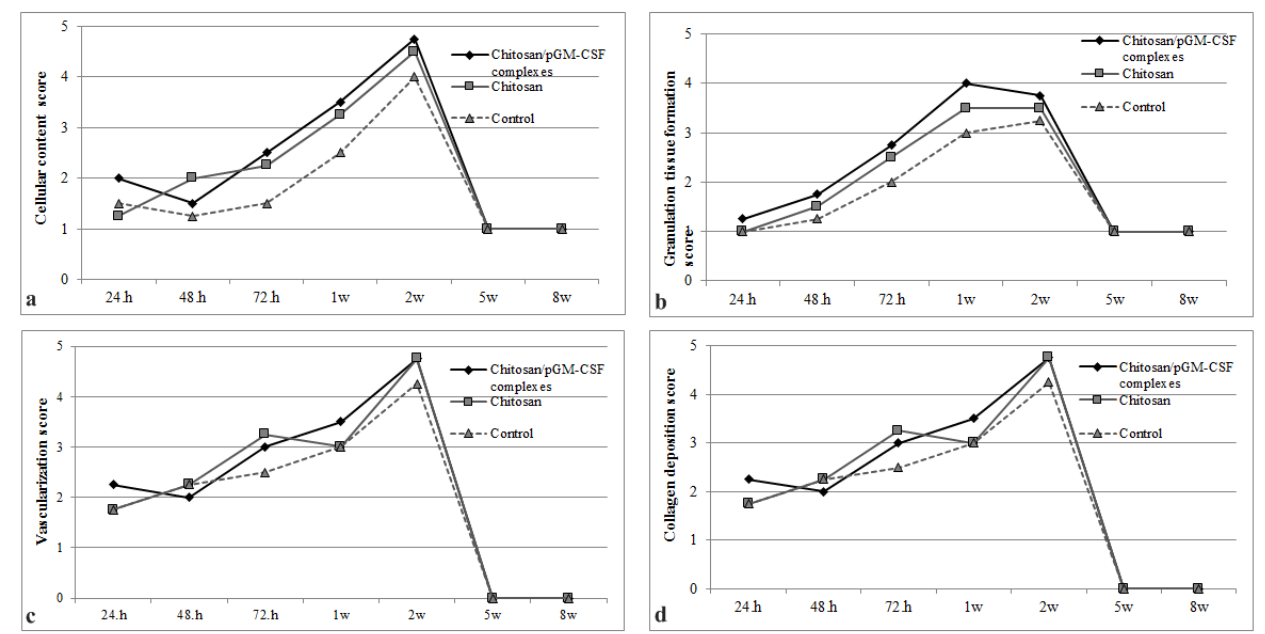
FIGURE 8 - Changes in (a) cellular content score, (b) granulation tissue formation score (c) vascularization score, (d) collagen deposition score depending on